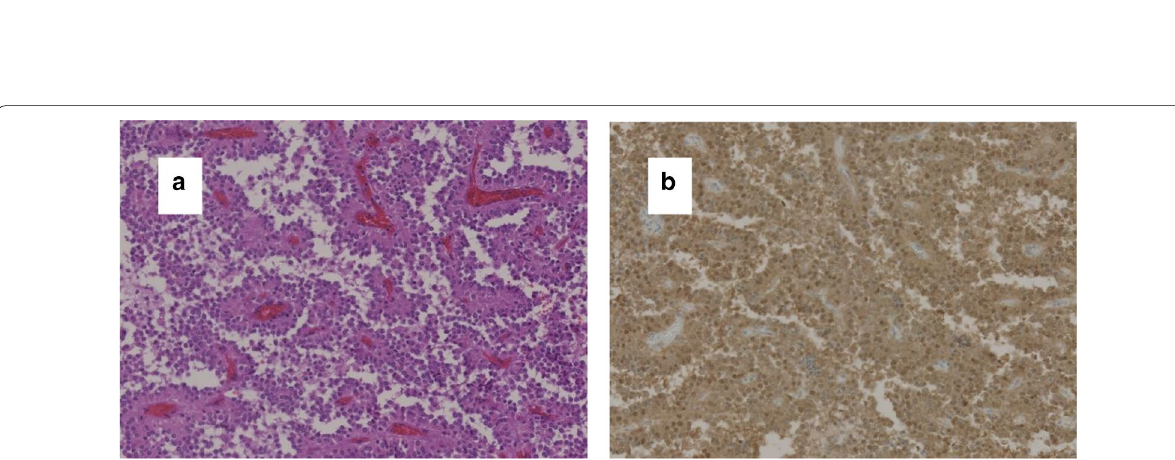
400). Immunohistochemical examination shows both nucleus and ×